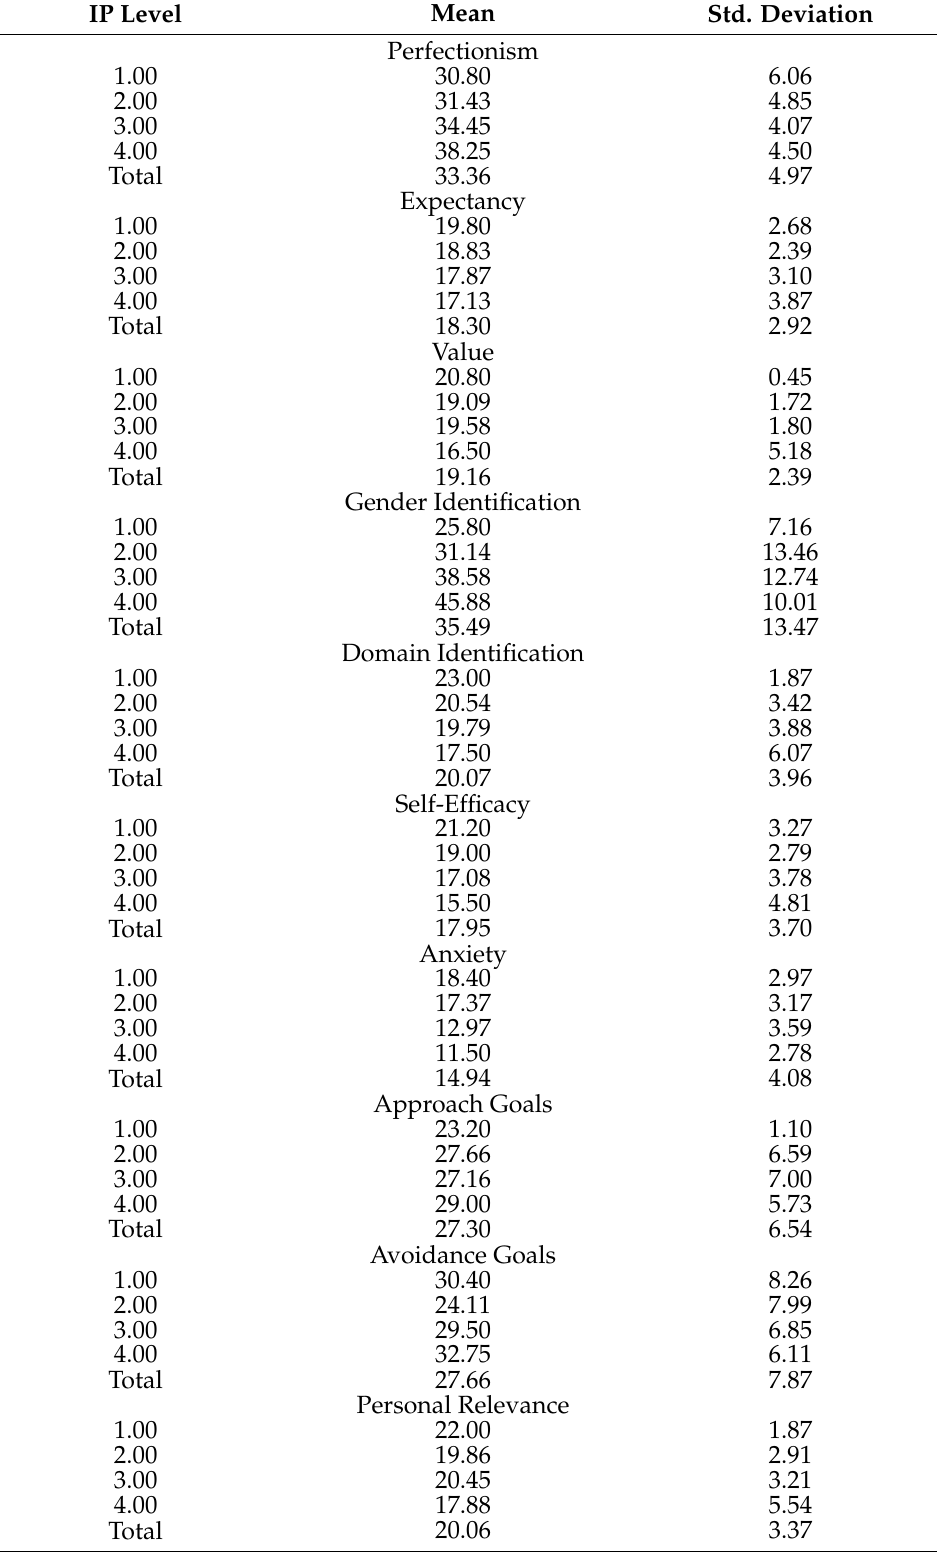
Table 2. Descriptive Statistics for IP Levels for Variables in the